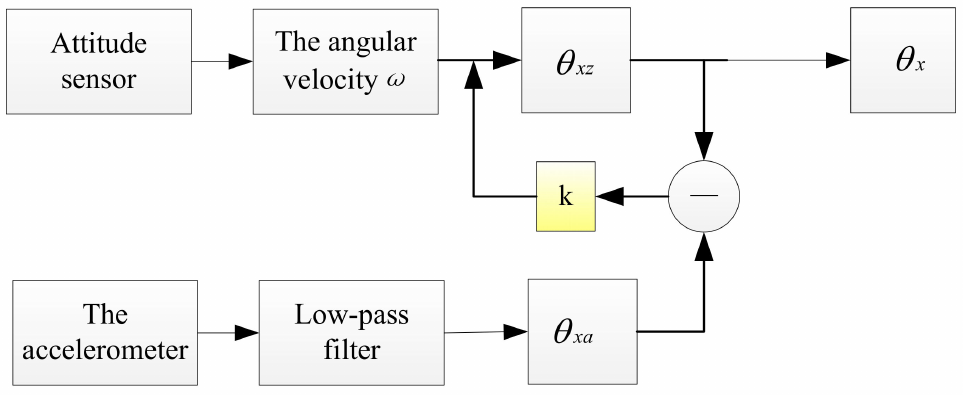
Figure 2. Schematic diagram of pitching complementary